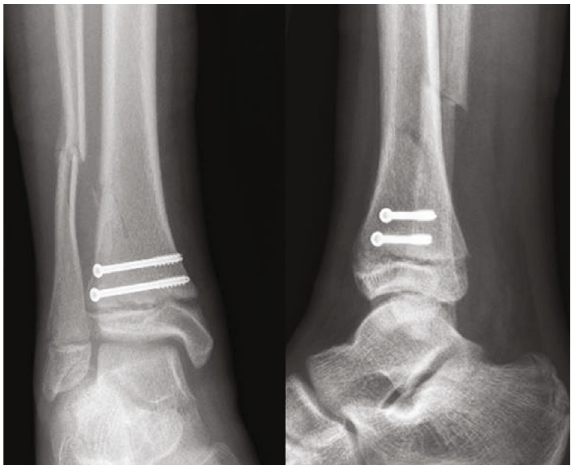
Figure 5: Postoperative radiograph in the anteroposterior and lateral views with fi xation by